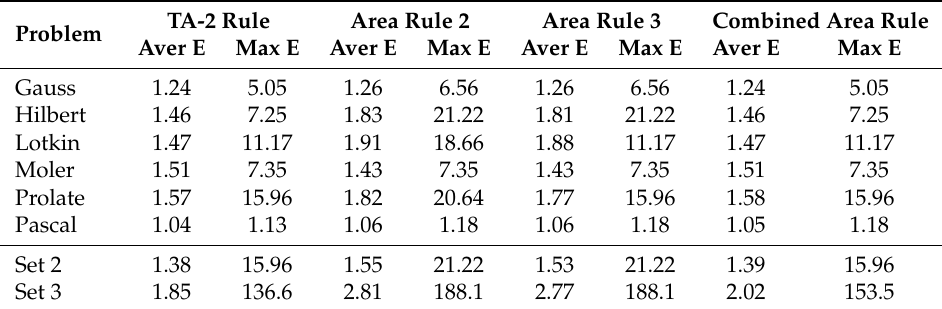
Table 7. Averages and maximums of error ratios E in proposed rules, problem sets 2 and 3. TA-2 Problem